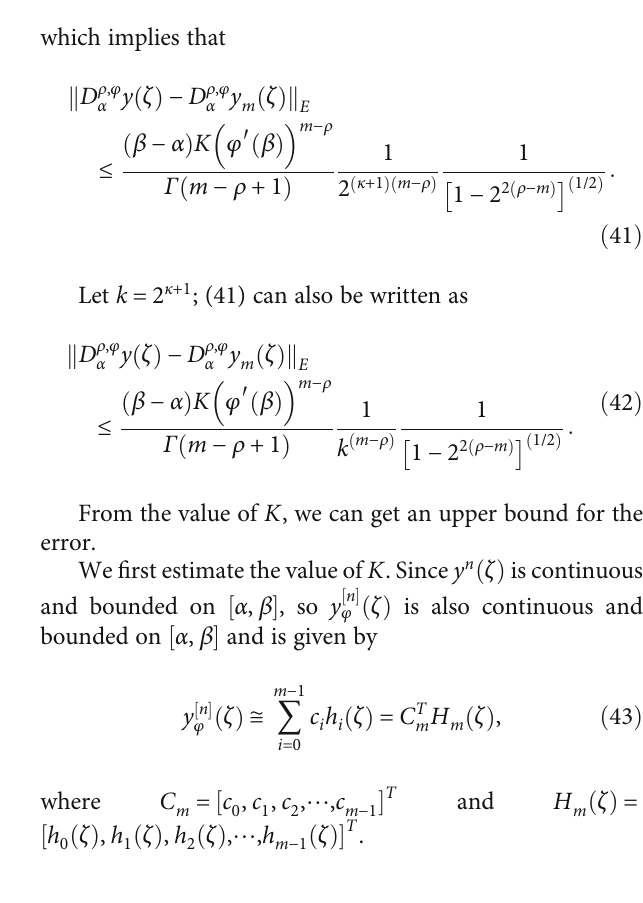
Figure 2: For J = 5 , ρ = 0 : 6 , and φ ð ζ Þ = sin ð ζ Þ : (a) approximate and exact solutions; (b) maximum absolute